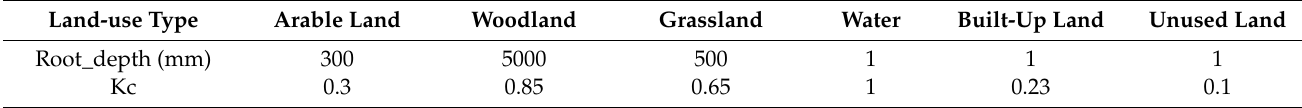
Table 3. Biophysical properties of each land-use type.